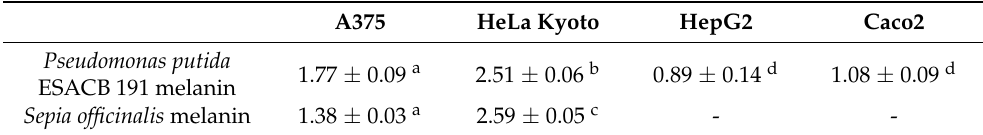
Table 3. Cytotoxicity of the Pseudomonas putida ESACB 191 and Sepia officinalis melanins against A375 and HeLa Kyoto cell lines, IC 50 values (mg/mL). The standard deviation values were calculated based on three replicates for each condition. Different superscript letters (a, b, c, d) correspond to values in the same assay condition that can be considered statistically different (95% confidence level). (-) not